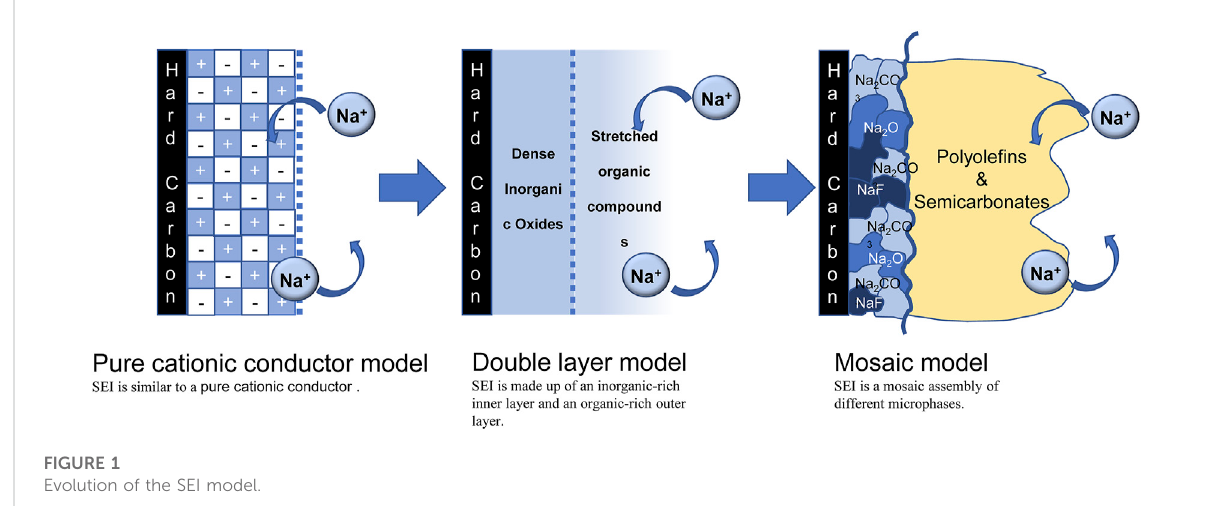
FIGURE 1 Evolution of the SEI